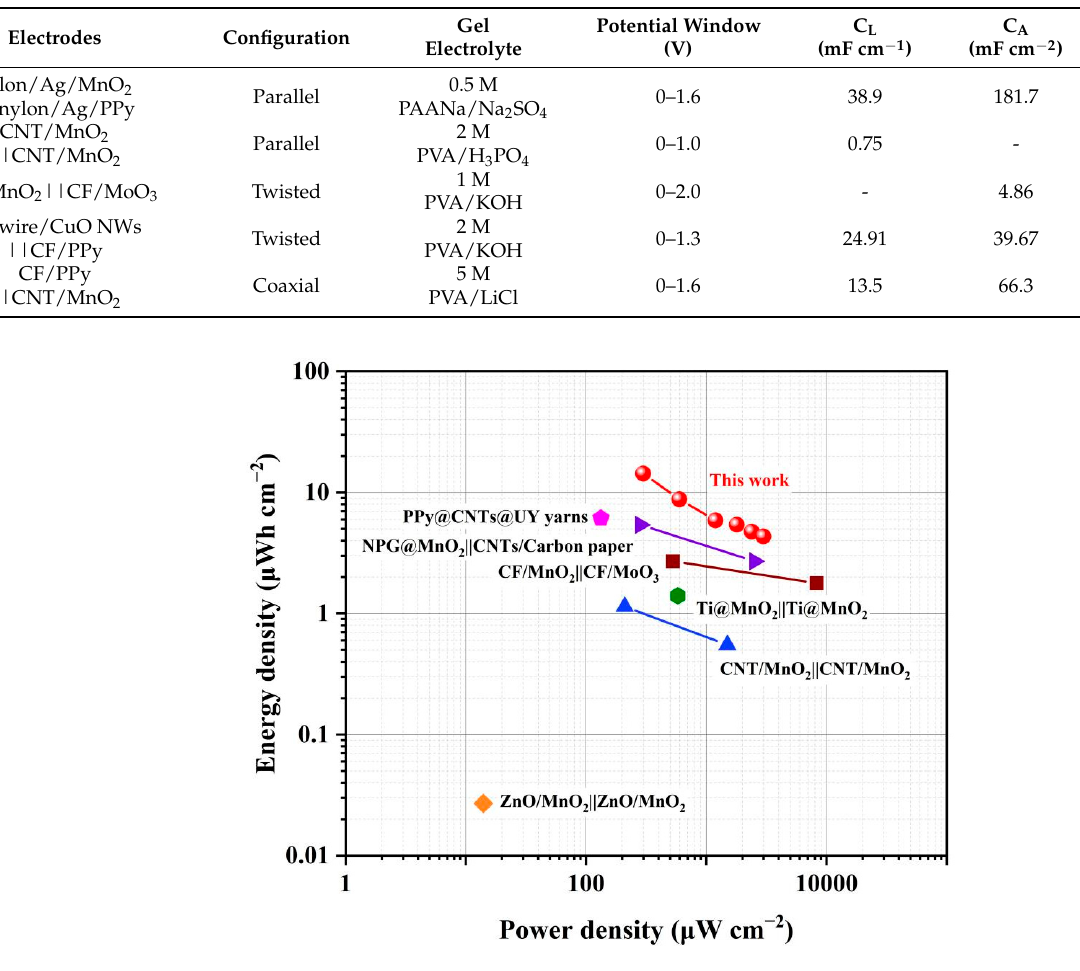
Table 2. Comparison of the electrochemical performance of this work and similar reported works.